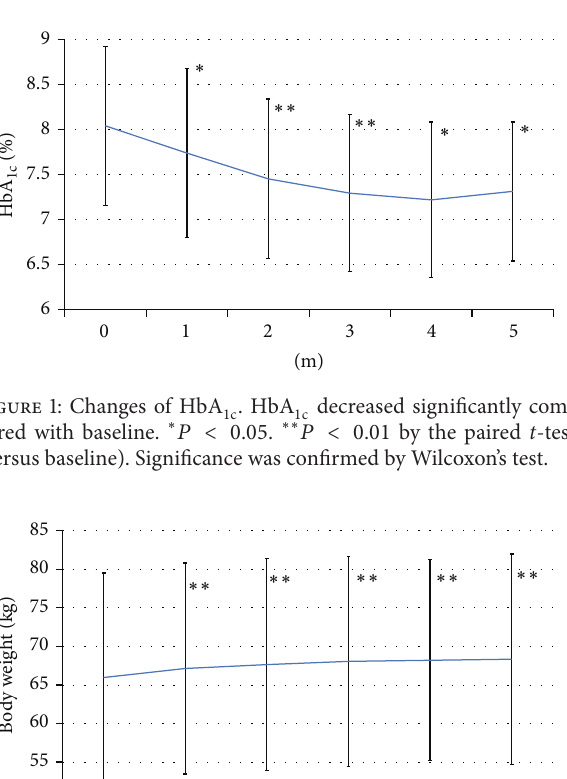
Table 1: Baseline characteristics of patients.